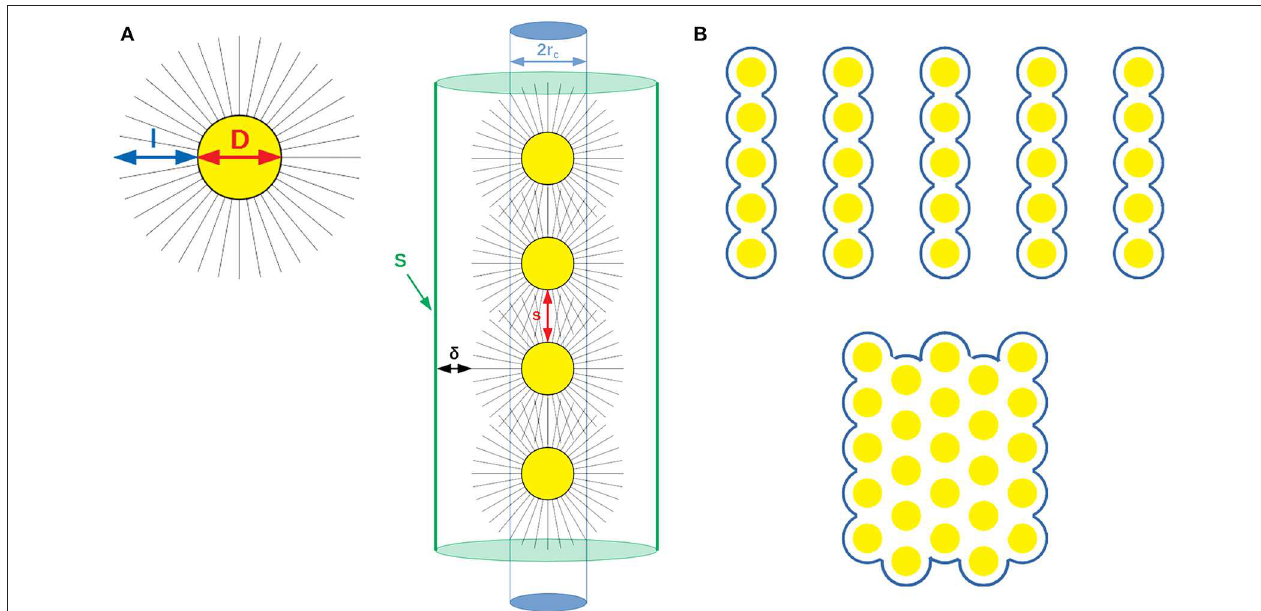
FIGURE 4 | (A) Model of the NPs with dodecanethiol ligands of length l and model of the NP chain with the disordered zone along the length δ shown beyond the ligands, of surface S shown in green. The dislocation core is schematically shown in blue. (B) Comparison of the surfaces of NP chains and NP FCC cube